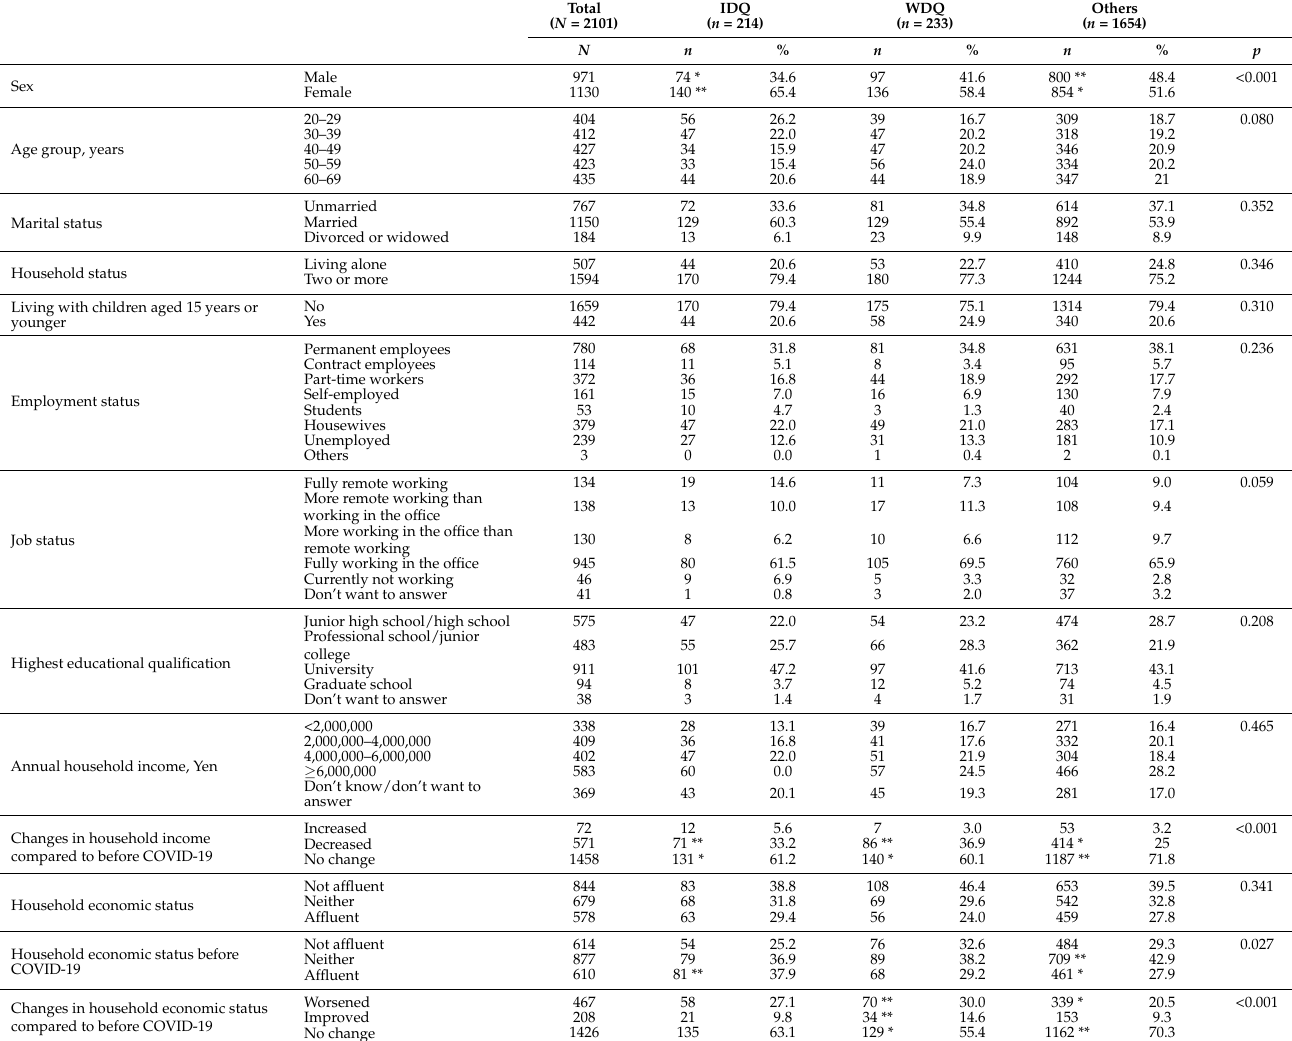
Table 1. Characteristics of participants according to changes in diet